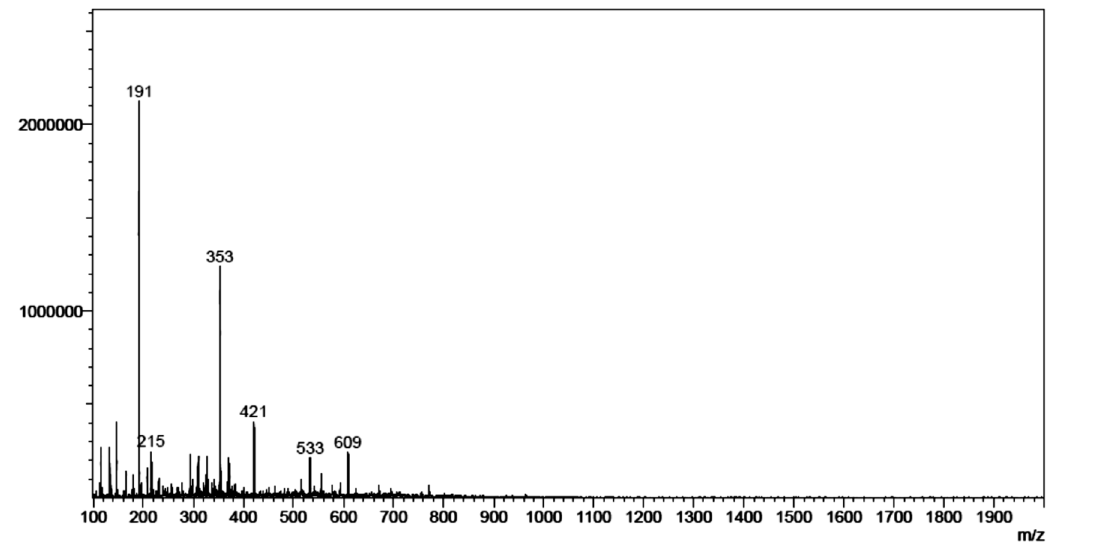
FIGURE 1 - First order mass spectrum in full-scan mode of the C. arabica L. dry extract analyzed in negative mode by FIA-ESI- MS². Range of ions m/z 100 to 1900